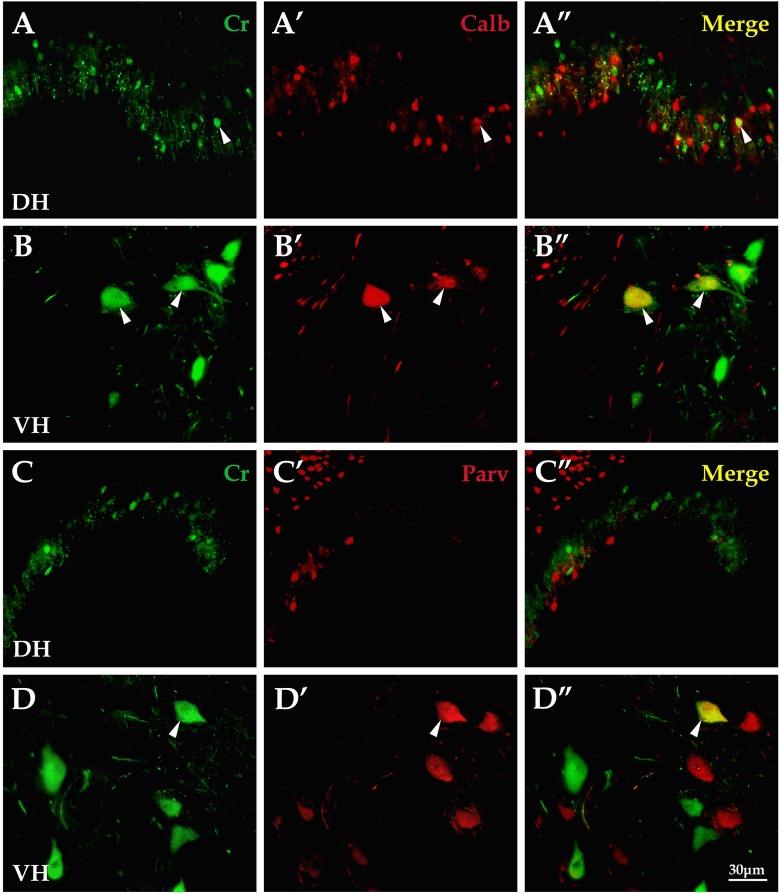
The detection of co-existence relation for Cr with Calb and Parv in the spinal cord.Layers I-II(A-A″) and ventral horn (B-B″),respectively, showed Cr (green), Calb (red), and Cr-Calb co-existence neurons (yellow). Layers I-II (C-C″) and the ventral horn(D-D″) respectively, showed Cr (green), Parv (red), and Cr-Parv co-existence neurons (yellow).Cr, Calb and Parv are short for Calretinin, Calbindin-D28k, Parvalbumin, and DH and VH are short for the dorsal horn and the ventral horn, respectively. All images are the same magnification.Scale bar: 30μm.